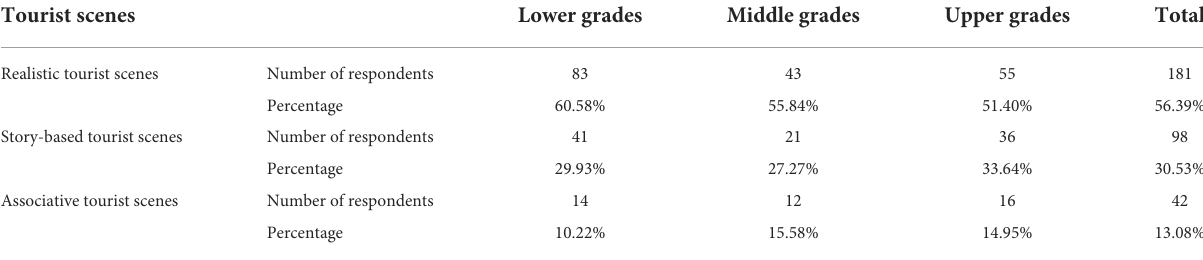
TABLE 5 Statistical analysis of tourist scenes in parent-child tourism. Tourist